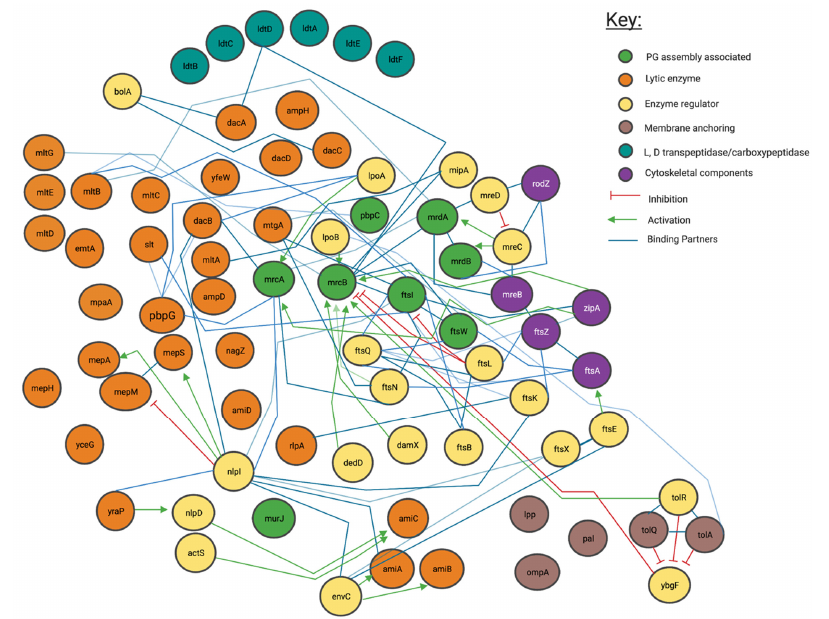
Figure 3. Interaction network of peptidoglycan modifying enzymes and their partners from Literature inspection. Interaction map of peptidoglycan-associated proteins sorted by enzymatic action. Network structure determined by STRING, with manual addition of interactions through literature associated with each protein. Reference matrix available in Appendix